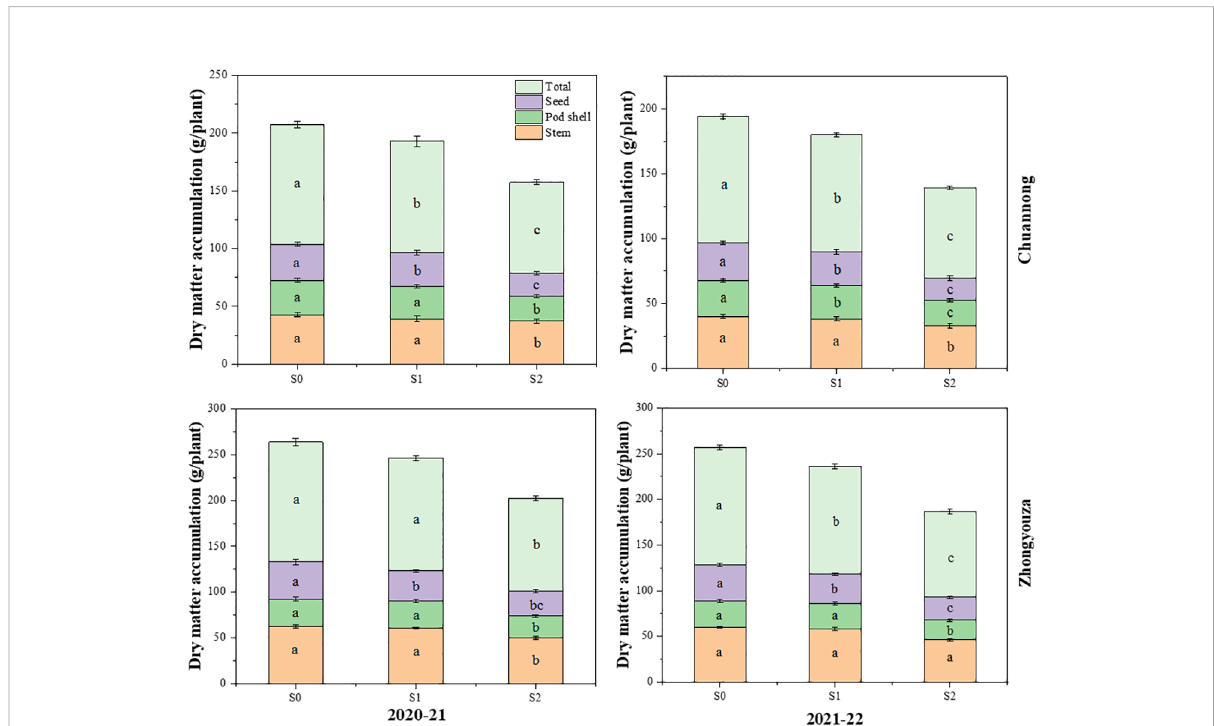
FIGURE 4 Effect of shading on dry matter accumulation in rapeseed. S0= control (ambient light); S1= shade at the whole fl owering stage and S2= shade at the start of pod development to pod maturity. Values were determined using the (n=10) LSD test, and various small letters denote the signi fi cance level of treatments at the 0.05 probability level (Duncan